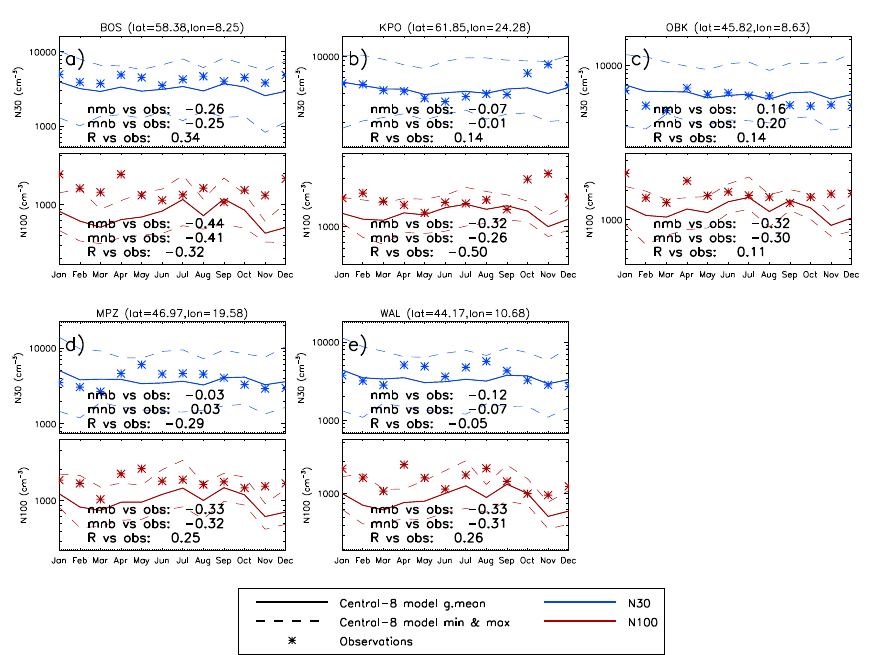
Figure 13. Annual cycle of simulated N(D p > 30nm) (blue) and N(D p > 100nm) (red) against those measured by SMPS/DMPS instru- ments (asterisks) at the five low-altitude EUSAAR/GUAN sites classified as central European: Bosel (BOS, a ), K-Puszta (KPO, b ), Kosetice (OBK, c ), Melpitz (MEL, d ) and Waldhof (WAL, e ). Model values are the geometric mean (solid) and min/max (dashed) over the central- 8 model monthly (arithmetic) mean values. Observed values are arithmetic means over the hourly measurement data (A. Asmi, personal communication,